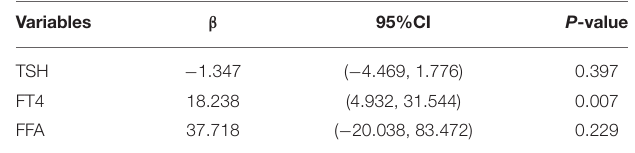
TABLE 2 | Association of VA and thyroid function. TABLE 3 | Regression analysis of VA and thyroid